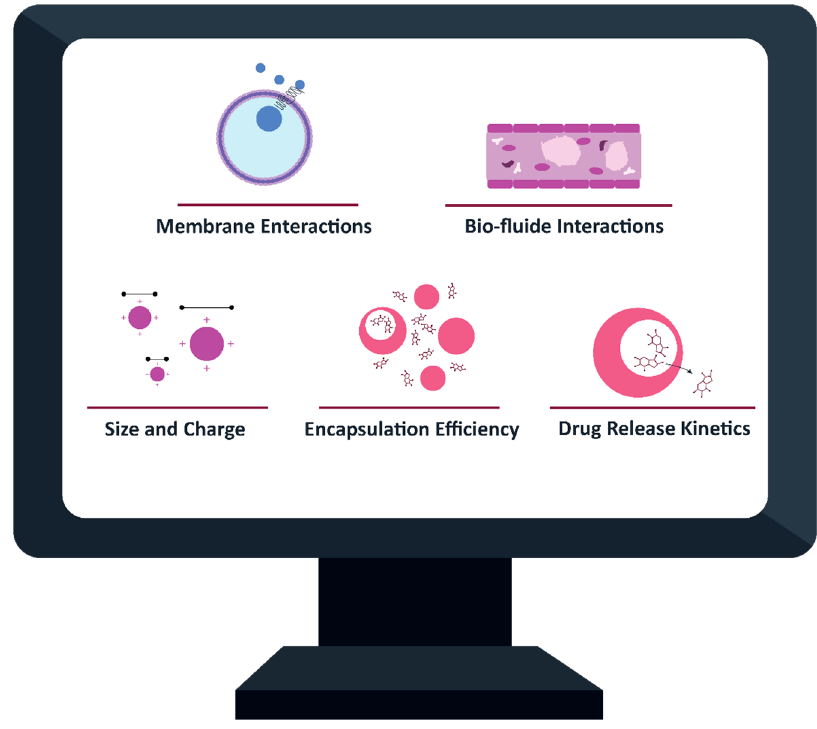
Figure 3. Computational methods promote different aspects of NP design. Available computational models and ML algorithms allow the prediction of NP charge and size, drug EE%, engaging with biomembranes, biofluids, and drug release kinetics; adapted from [55].